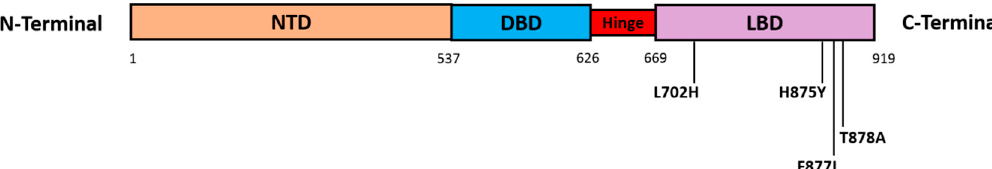
Figure 3. AR somatic missense mutations. The main four missense mutations that are focused on in this review all occur in the AR LBD ( AR exons 5–8) and include: L702H, H875Y, F877L (previously published as F876L), and T878A (previously published as T877A). Abbreviations: DBD, DNA binding domain; LBD, ligand binding domain; NTD, N-terminal transactivation domain.